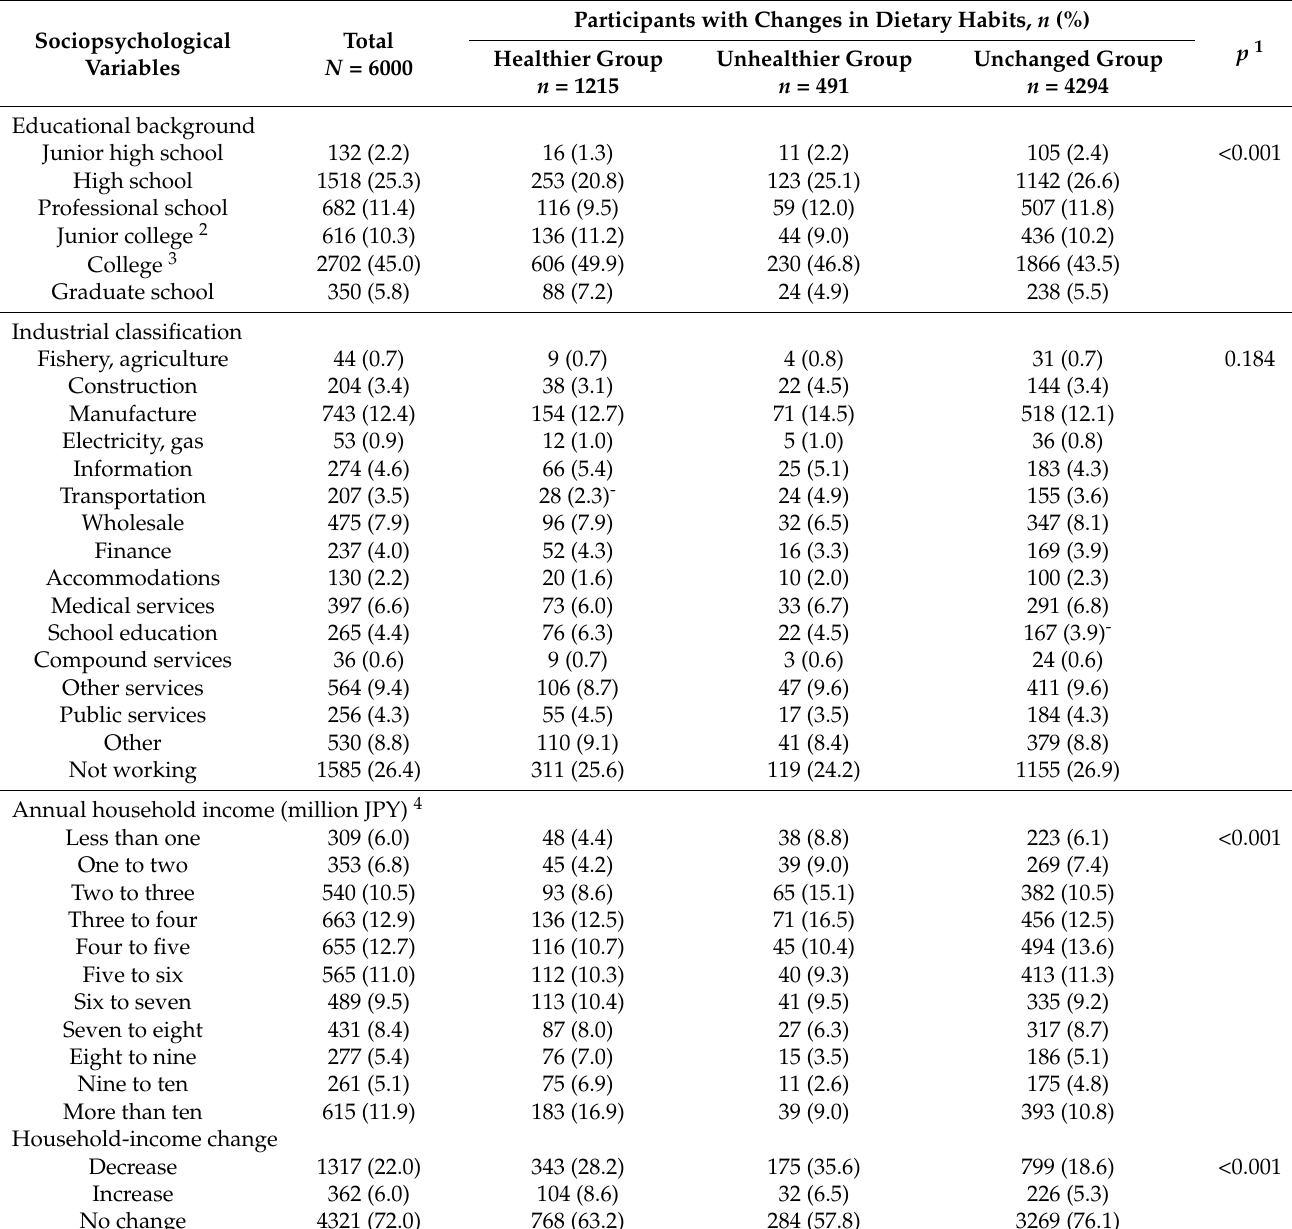
Table 2. Comparison of sociopsychological variables among the healthier, unhealthier, and unchanged groups.